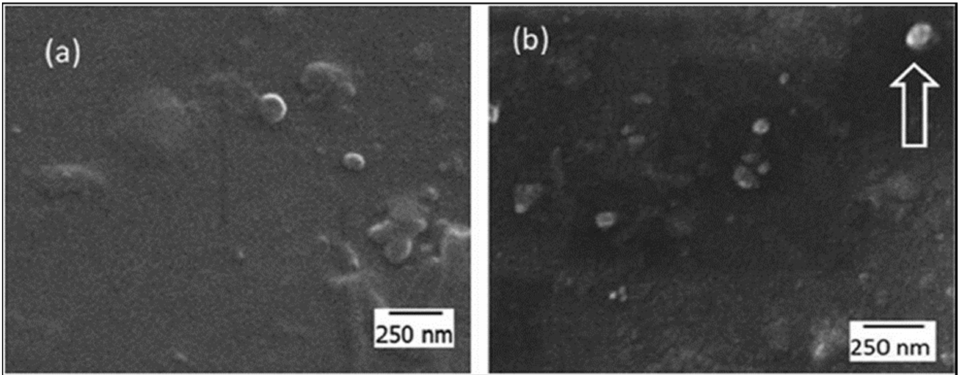
Figure 40. Dispersion of CNS particles: ( a ) 0.1 wt% CNS–epoxy and ( b ) 0.25 wt% CNS–epoxy composite with agglomerations of 125 nm (indicated by arrow)